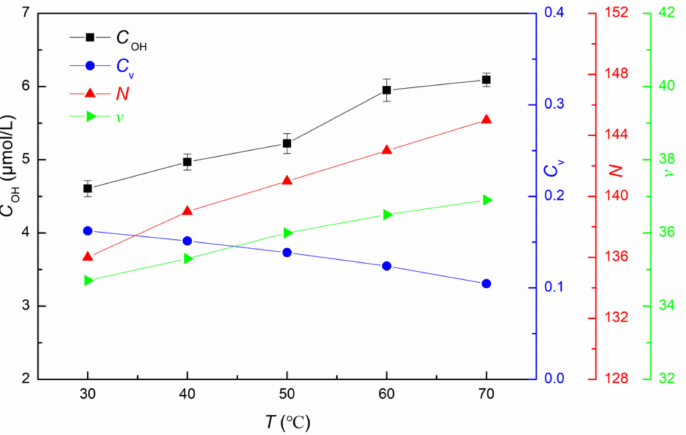
Figure 8. Influence of temperature on · OH yield, C v , N , and v values. (Conditions: P i = 0.4 MPa, d = 0.5 mm, t = 50 min, V = 150